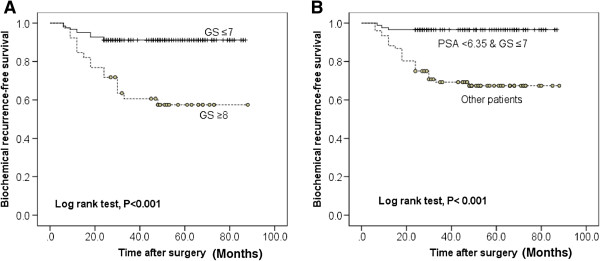
Kaplan-Meir curves predict the biochemical recurrence. (A) Biochemical recurrence (BCR)-free survival according to Gleason score. (B) Eighty-seven patients who met the criteria composed of lower pre-operative PSA cutoff (6.35 ng/ml) and surgical GS ≤ 7, there were only 3 patients had BCR.